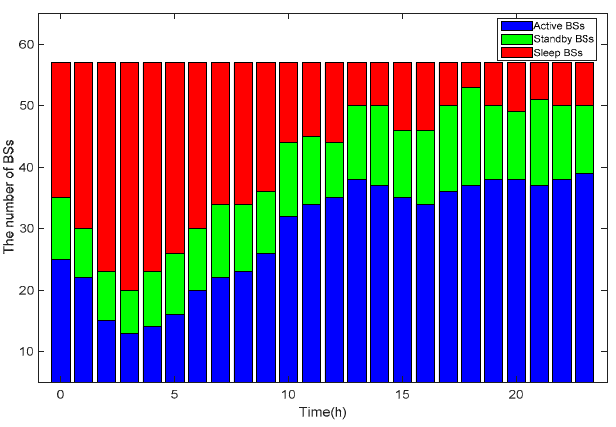
Figure 14. Number of base stations in different states of SSC-UA scheme.